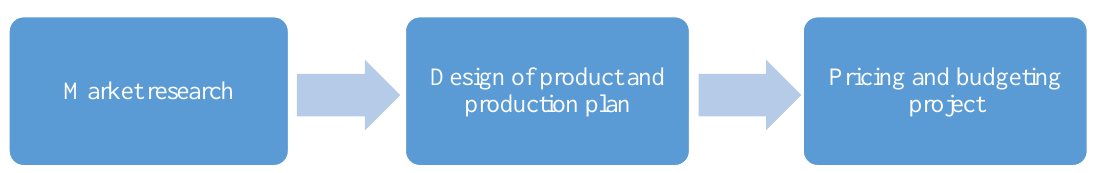
Figure 7. Work packages of living room furniture design and market entry